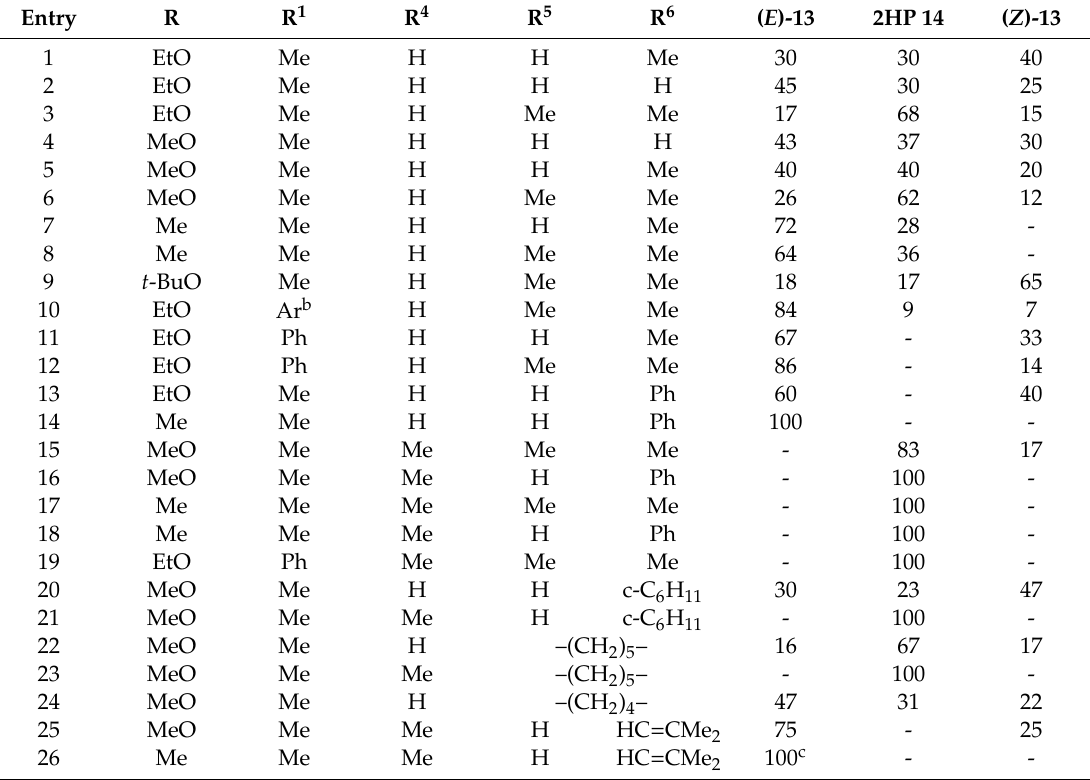
Table 1. α -Acyl-dienones 13 and their equilibrium isomeric compositions.